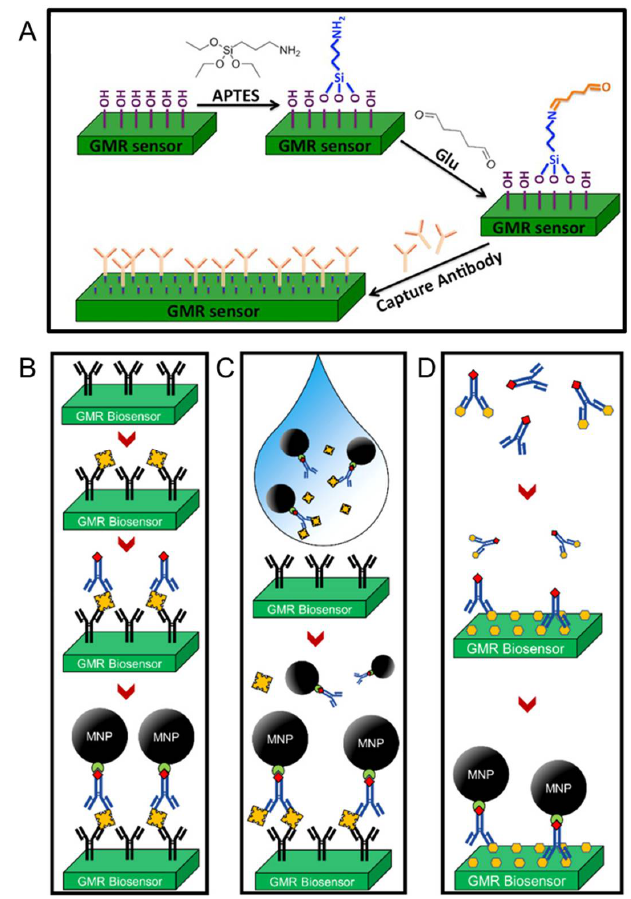
Figure 4. Schematic diagram of ( A ) surface modification and capture probe conjugation via the APTES/Glu method, ( B ) establishment of a traditional sandwich bioassay, ( C ) establishment of a wash-free sandwich bioassay, and ( D ) establishment of a competitive bioassay. ( A ) is reprinted with permission from Ref. [89], under the terms of the Creative Commons Attribution License (CC BY). ( B – D ) are reprinted with permission from Ref. [34], Copyright 2022, American Chemical Society.